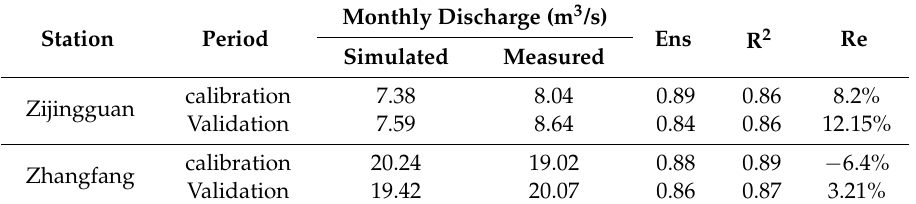
Table 3. The results of calibration and validation.